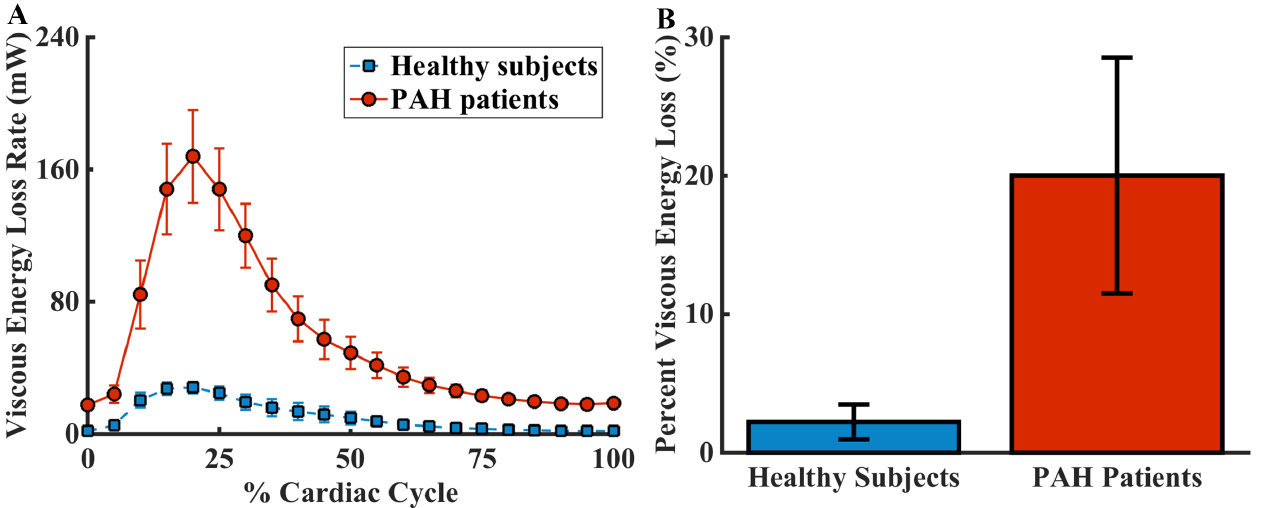
Fig 4. Comparing viscous energy loss in healthy subjects and patients with pulmonary arterial hypertension. (A) The amount of viscous energy loss is higher in patients throughout the cardiac cycle. (B) The percent viscous energy loss is significantly greater in PAH patients than in healthy subjects (21.1 ± 6.4% vs. 2.2 ± 1.3%, p =